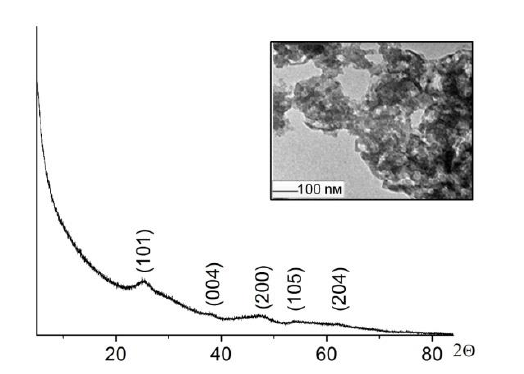
Figure 4. XRD pattern and TEM image of TiO 2 nanophase used for preparation of heterostructure